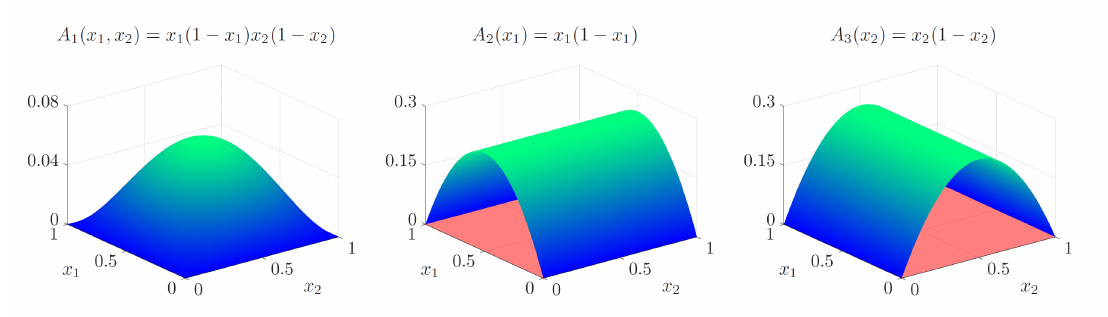
Figure 7. Visualization of the functions A 1 , A 2 and A 3 ensuring periodicity of the two-dimensional trial function (cid:101) φ t in a square RVE of unit length l = 1. One can see that A 1 covers the volume, A